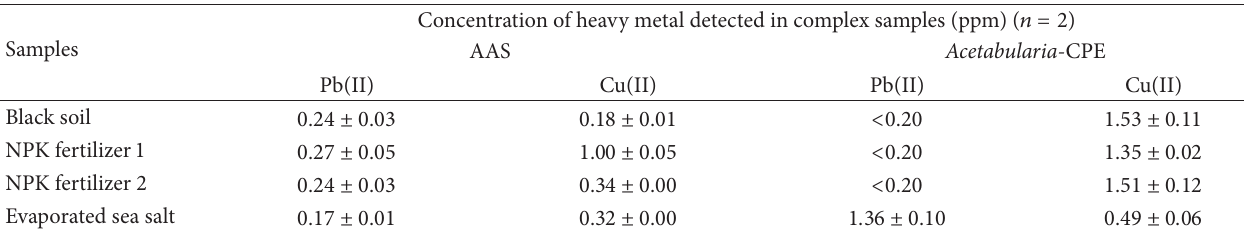
Table 3: Summary of concentrations of complex samples as suggested by various analytical